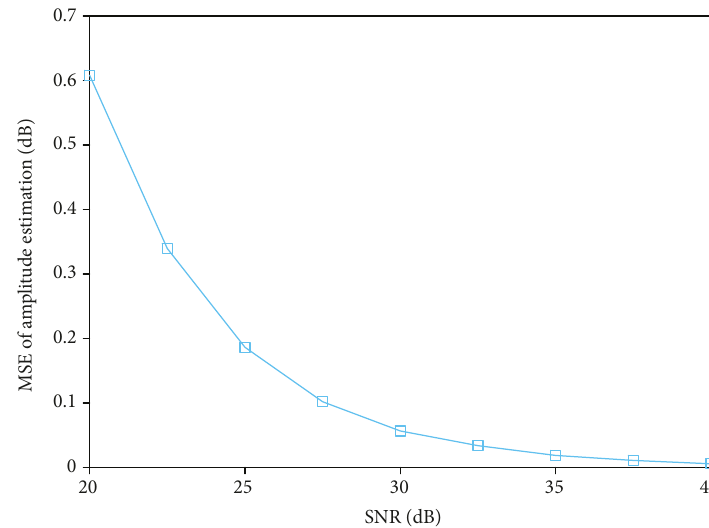
Figure 9: The amplitude calibration error under di ff erent SNR conditions.